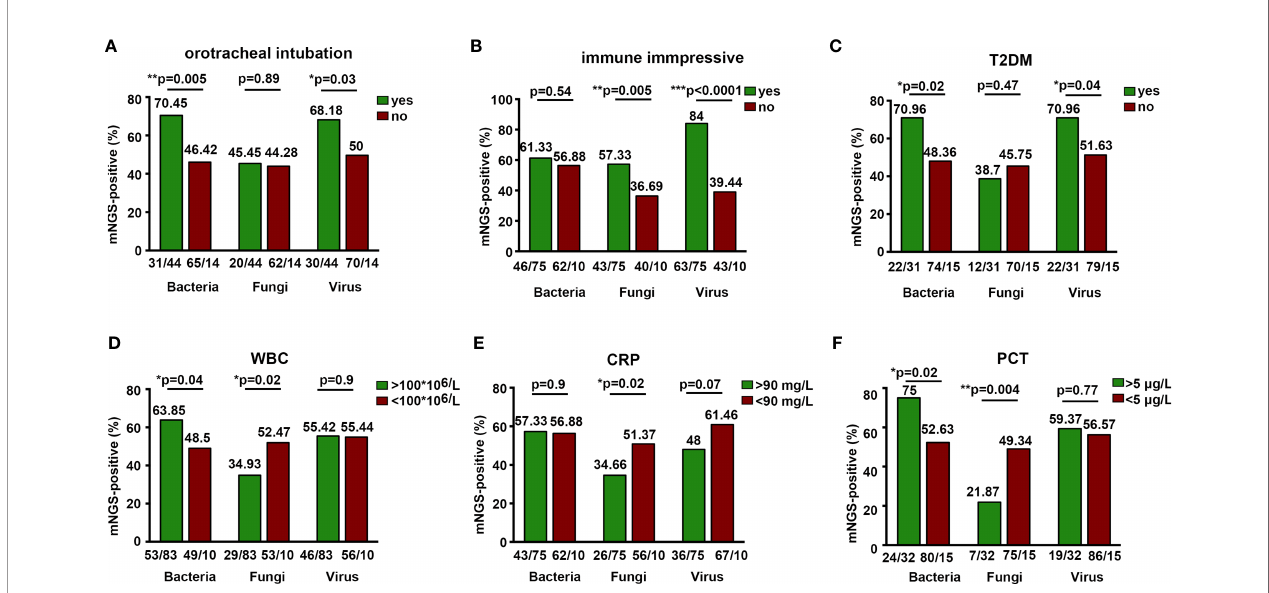
FIGURE 4 | Positive detection rate of mNGS associated with clinical characteristics. * P < 0.05, ** P < 0.01, *** P <